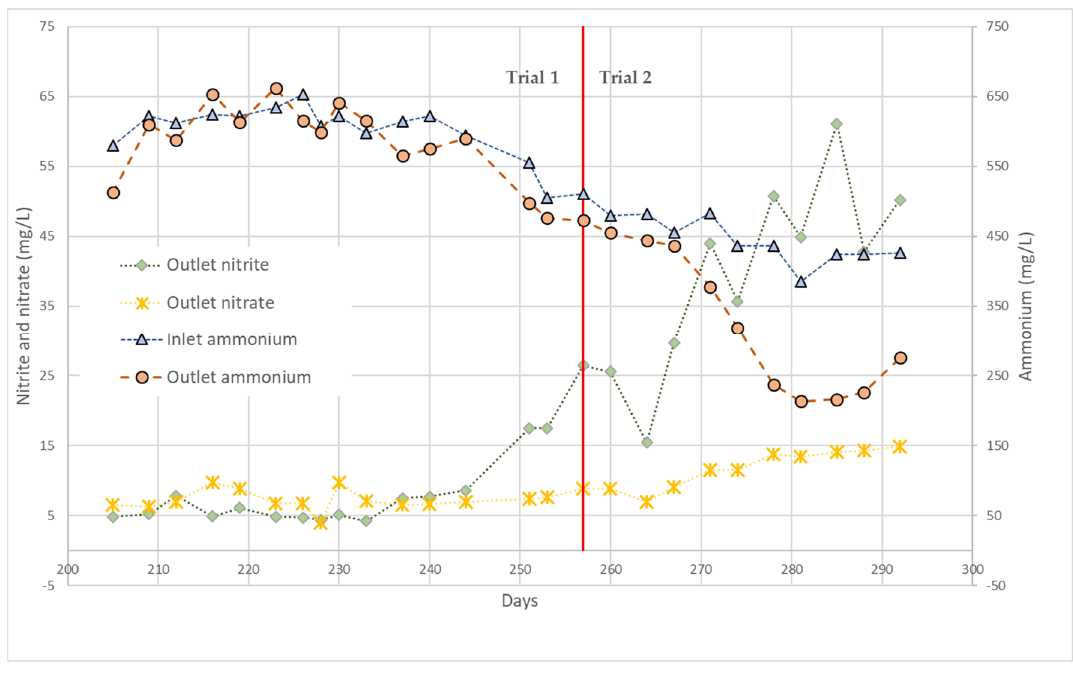
Figure 8. Nitrogen species variation in the HyVAB reactor.